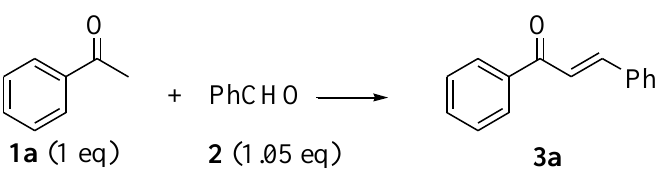
Entry SSA (g) Solvent Time (Temperature, °C) %Yield ¥